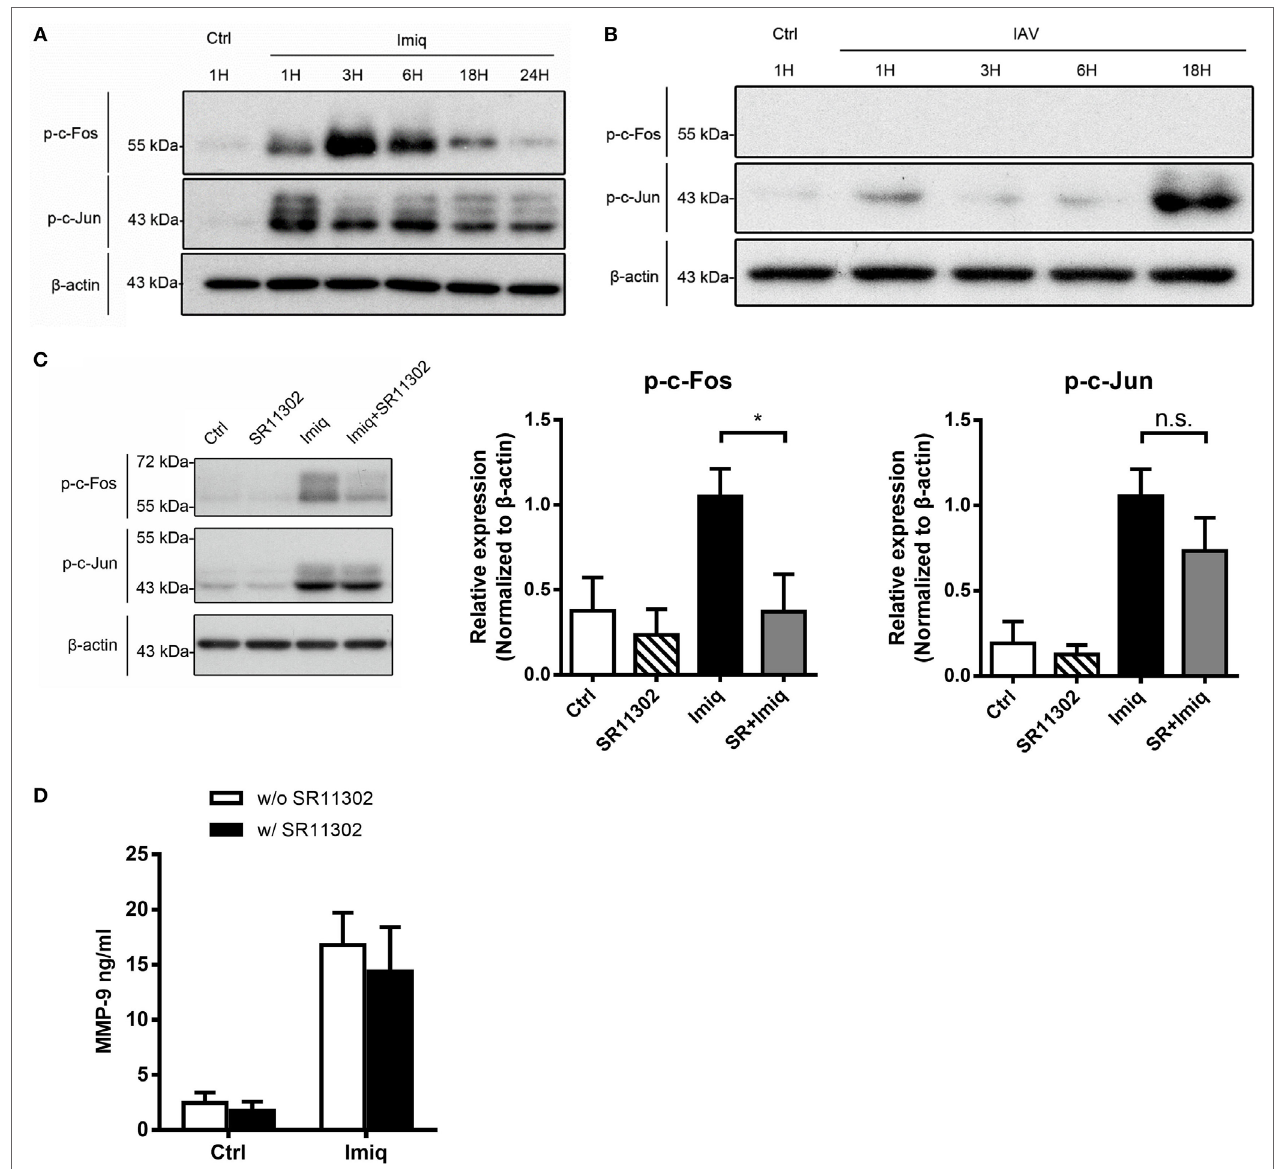
FigUre 3 | Alveolar macrophage matrix metalloproteinase-9 (MMP-9) production is independent of activator protein 1 (AP-1). MH-S cells were stimulated (a) with or without imiquimod (Imiq, 1 µg/ml) and (B) WSN virus (MOI = 0.25) for indicated periods of time. (c) MH-S cells were pretreated with or without SR11302 (AP-1 inhibitor, 10 µM) for 1 h before stimulation with or without Imiq (1 µg/ml) for another 3 h. (a–c) Phosphorylated c-Fos and c-Jun in cell lysate were detected by Western blotting [Panel (a) , n = 3; Panel (B) , n = 3; Panel (c) , n = 6. One representative experiment is shown]. Bar graphs show the levels of indicated protein normalized against β -actin. (D) MH-S cells were pretreated with or without SR11302 (AP-1 inhibitor, 10 µM) for 1 h before stimulation with or without Imiq (1 µg/ml) for another 18 h. The concentration of MMP-9 in culture supernatants was quantified by ELISA ( n = 3, three independent experiments). n.s., not significant, * p < 0.05, compared to control. (c,D) were analyzed by one-way ANOVA followed by (c) Kruskal–Wallis and (D) Sidak’s post hoc